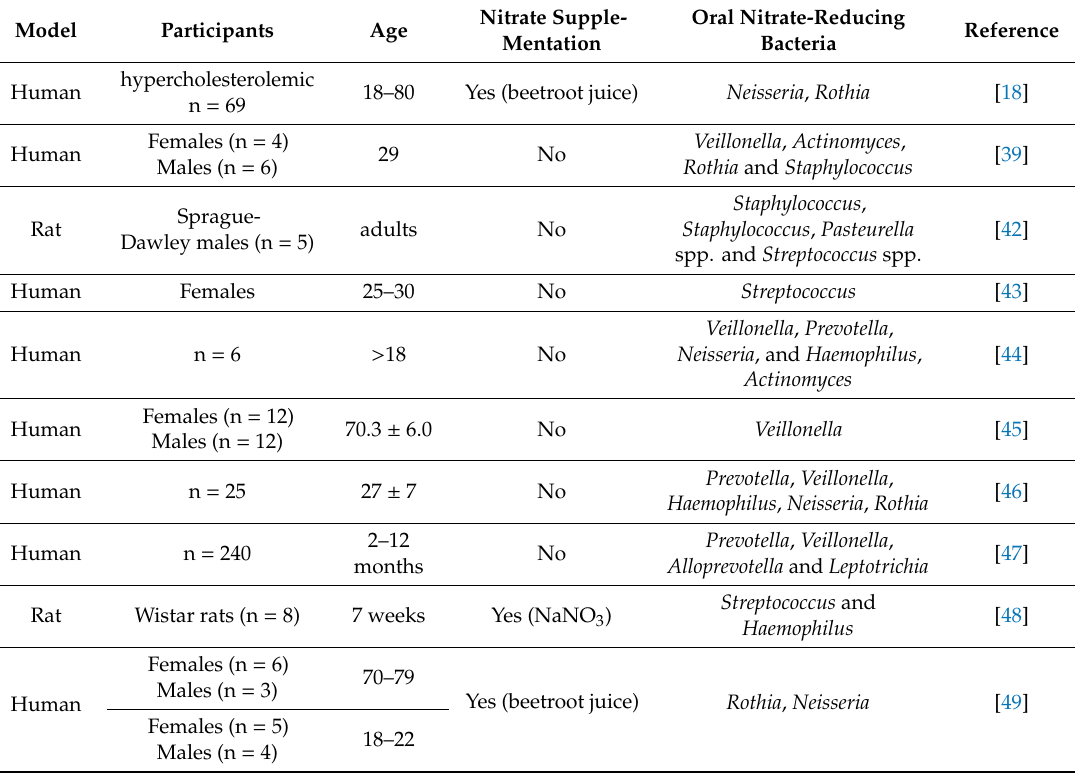
Table 1. Summary of studies identifying oral nitrate-reducing bacteria with or without nitrate supplementation.